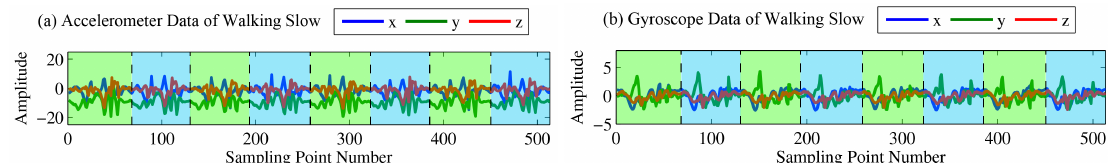
Figure 13. Accelerometer ( a ) and gyroscope ( b ) data of walking slowly.